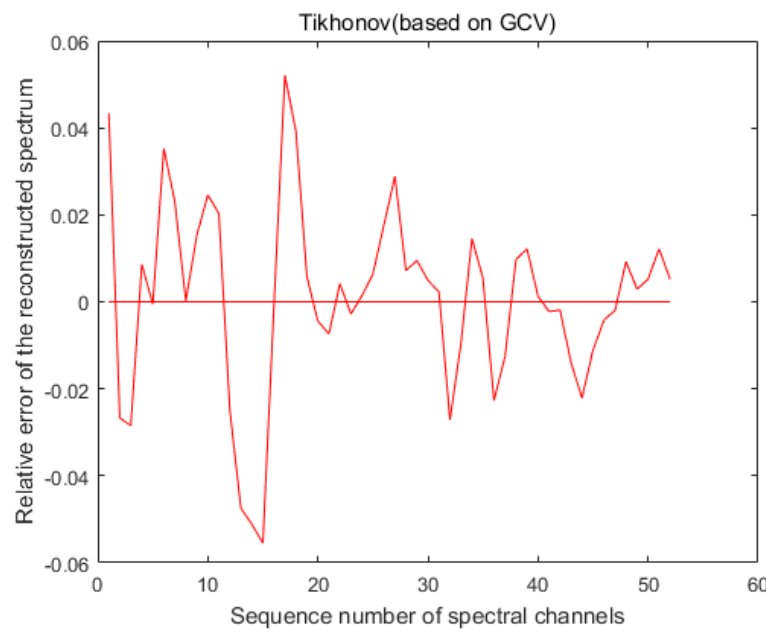
Figure 12. Maximum error in the reconstructed spectrum considering a detector SNR of 40